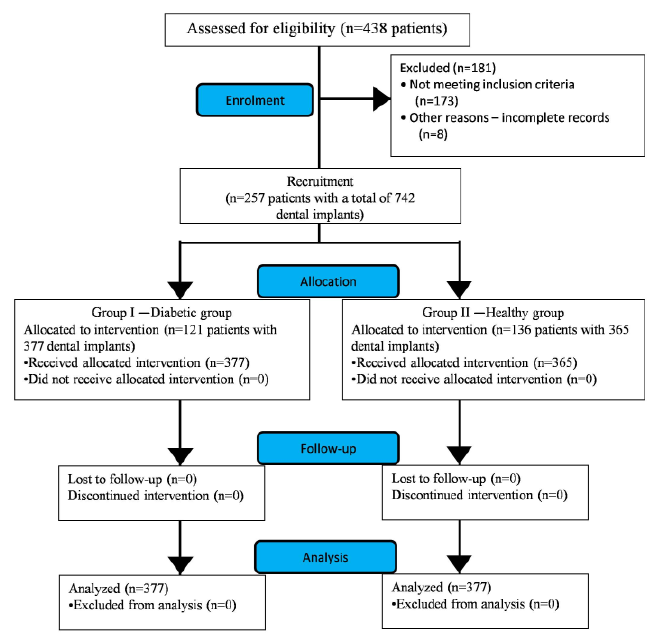
Figure 1. Flow chart showing the study design and recruitment of patients (CONSORT Statement).